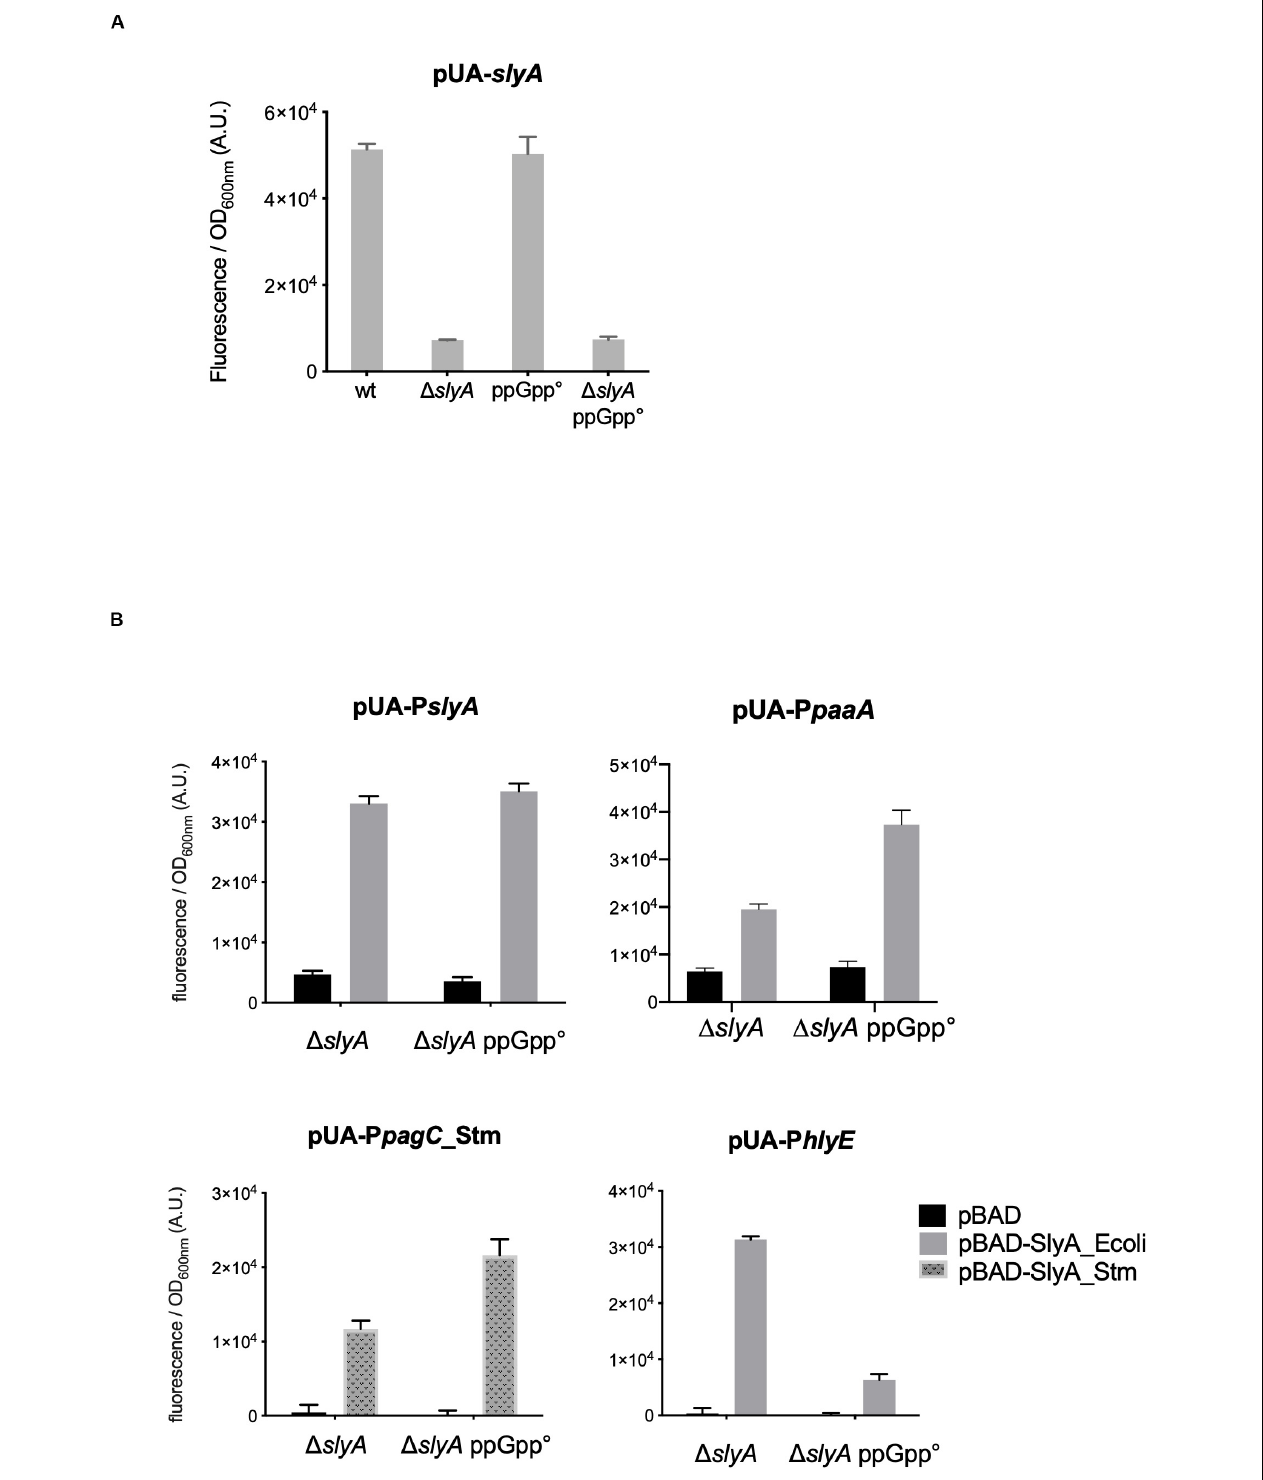
FIGURE 2 | In vivo induction by SlyA does not require ppGpp. (A) Comparison of slyA transcriptional fusion activity in wild type MG1655, (cid:49) slyA (EB1073), ppGpp ◦ (EB425), and (cid:49) slyA_ ppGpp ◦ (EB1077) strains grown overnight at 30 ◦ C in LB. (B) Effect of pBAD-SlyA overproduction in (cid:49) slyA or (cid:49) slyA_ ppGpp ◦ strains on the expression of slyA , paaA , pagC _Stm, and hlyE transcriptional fusions, in the same conditions as in Figure 1B . The activities correspond to the ratio between GFP fluorescence and OD 600 nm of six (A) or four (B) replicates, given in arbitrary units (A.U.). The error bars show the SEM.